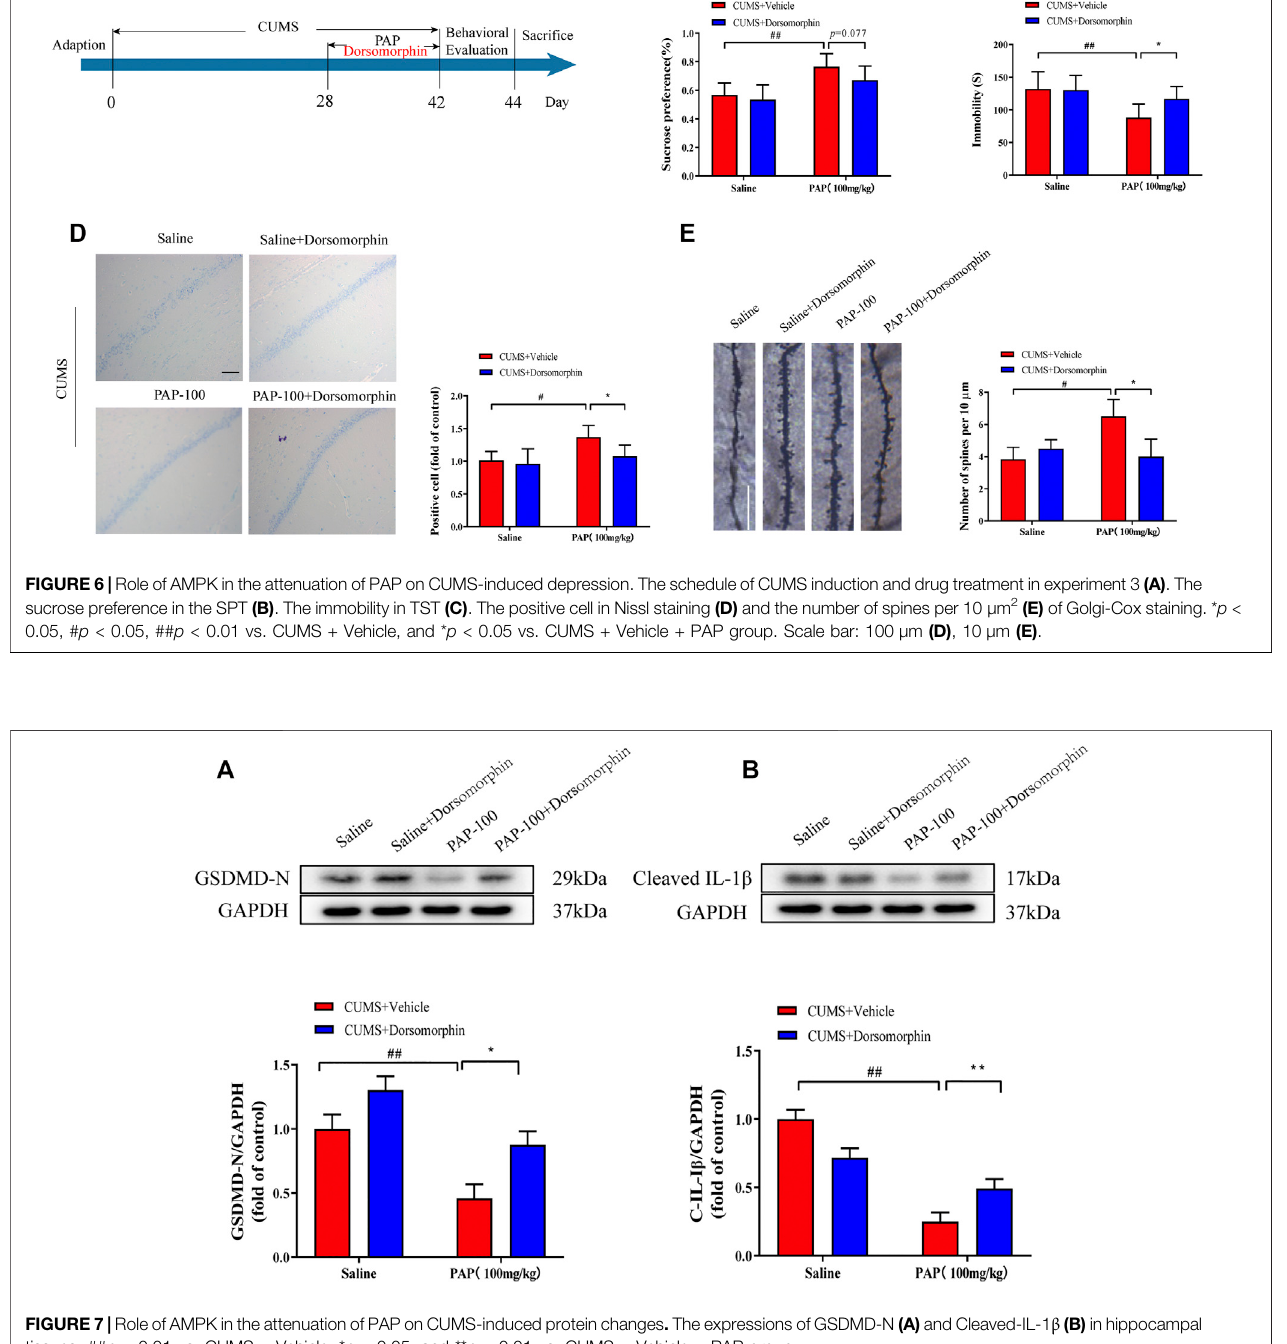
Frontiers in Pharmacology |